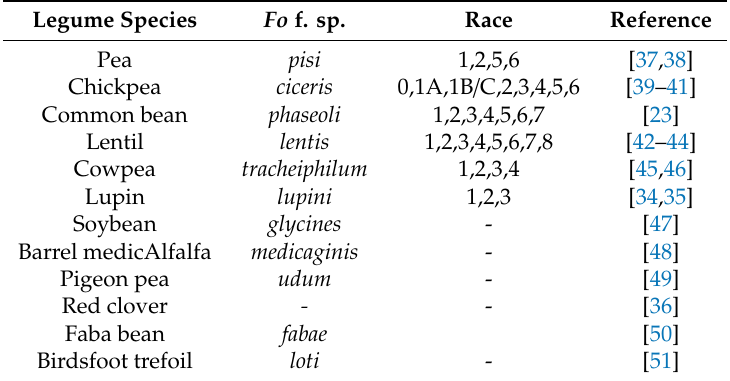
Table 1. Fusarium oxysporum ff . spp. and respective races causing Fusarium wilt in several legume species. Legume Species Fo f. sp. Race Reference Pea